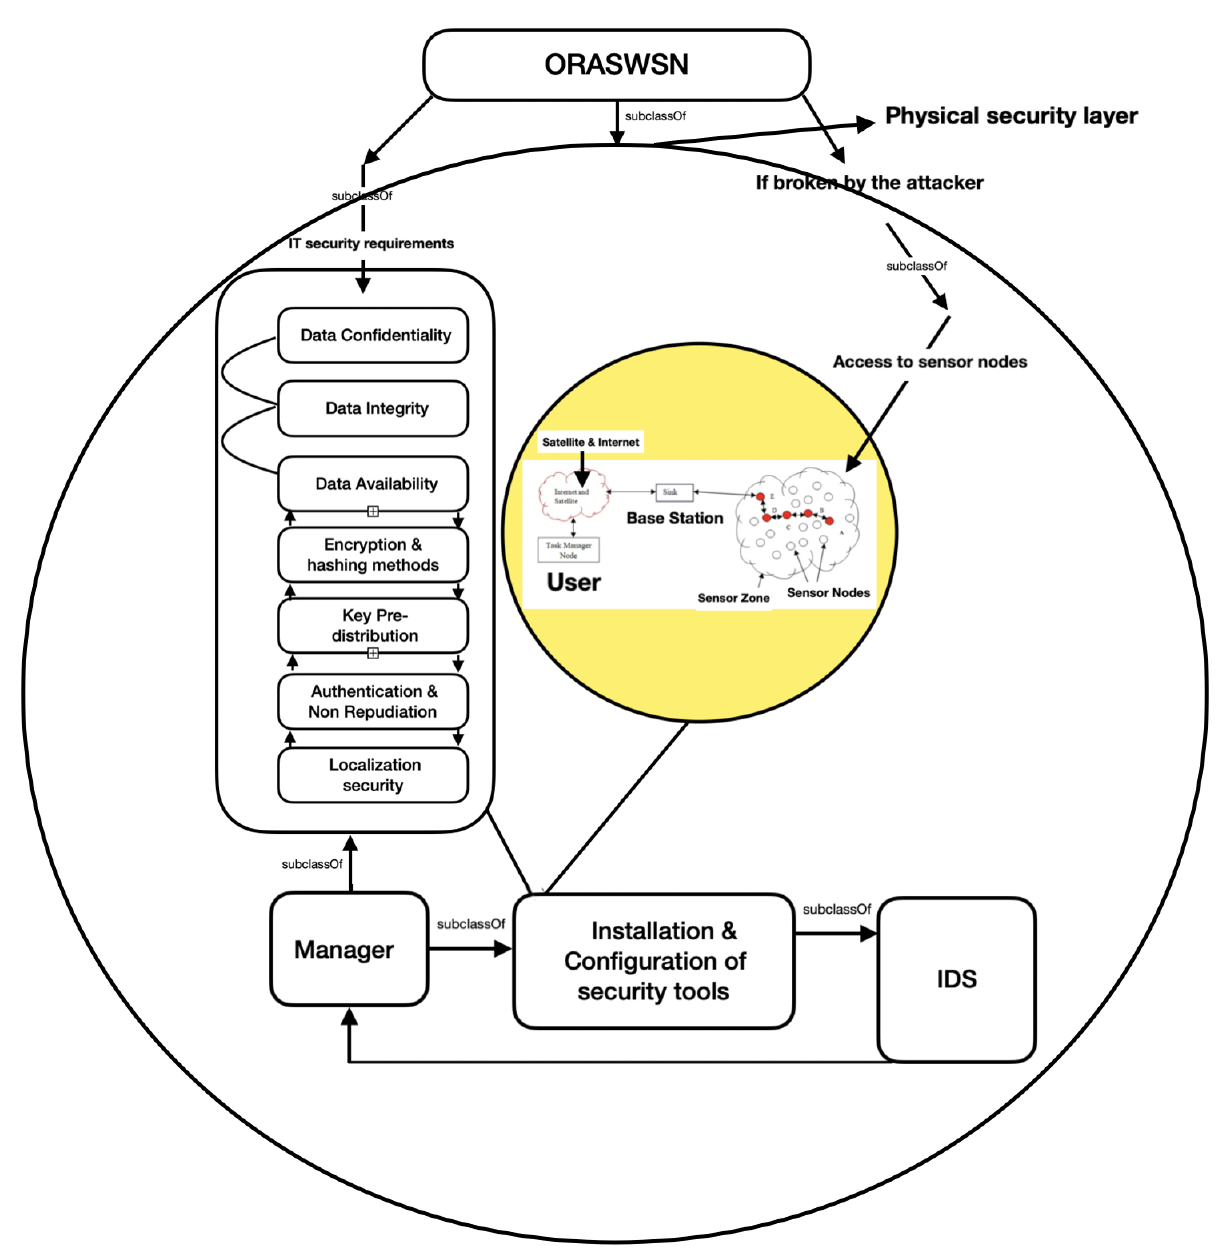
Figure 6. ORASWSN ontology-based approach in static